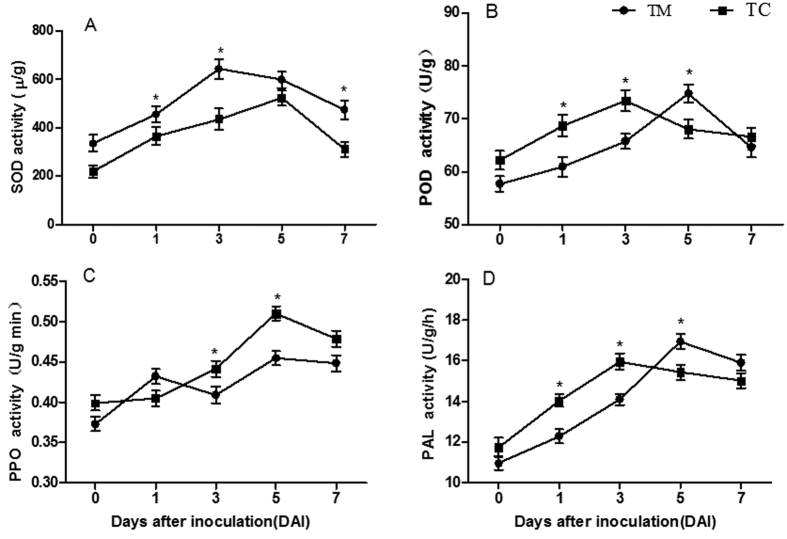
Enzyme activities of SOD, POD, PPO and PAL in tomato roots on different days after inoculation with V. dahliae. (A) SOD activity. (B) POD activity. (C) PPO activity. (D) PAL activity. TM indicates tomato monoculture; TC indicates tomato grown with potato onions. The data are presented as the means ± SD, n = 3. The asterisk (*) indicates a significant difference between two groups of mean values (p < 0.05).